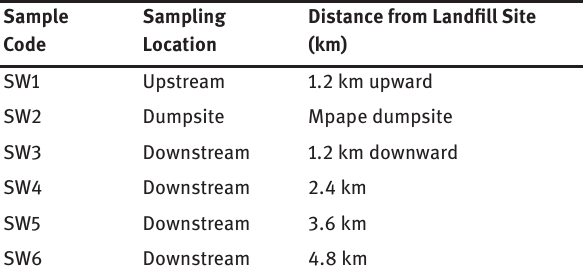
Table 1: Sample locations and codes used to denote the sampled sites.